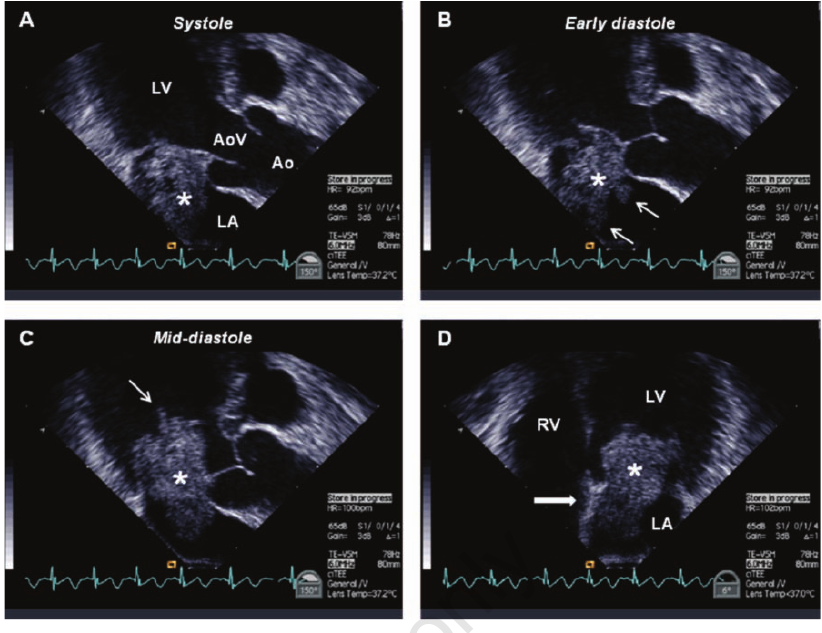
Figure 1. Multiple trans-esophageal images of a large left atrial myxoma (marked by *). Long-axis mid-esophageal views of the heart (A – systole, B – early diastole, C – mid-dias- tole) demonstrating prolapse of the myxoma from the left atrium into the left ventricle during diastole. Multiple, mobile, “finger-like” projections of the tumor were evident (thin arrows). Four-chamber mid-esophageal view (D) showing the connection of the tumor to the interatrial septum (thick arrow). LA = left atrium, LV = left ventricle, Ao = ascending aorta, AoV = aortic valve, RV = right